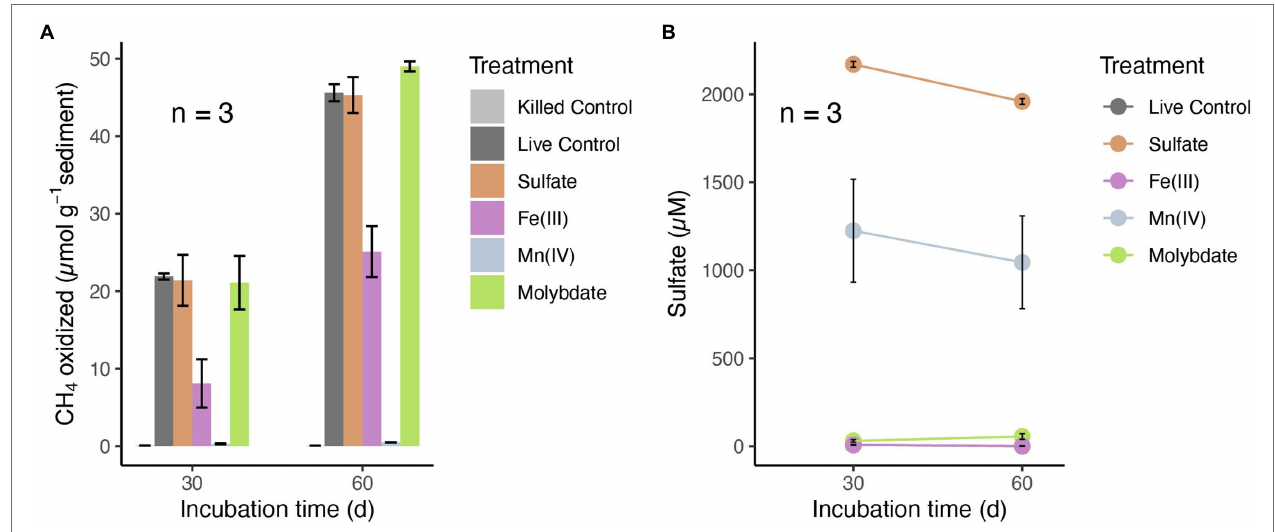
FIGURE 2 | (A) Methane oxidation in anoxic slurries with 14 C-labeled methane and different electron acceptors: sulfate (2 mM), amorphous iron(III) oxides (5 mM) and manganese(IV) oxides (5 mM) after 30 and 60 days, respectively. (B) Sulfate concentrations in the incubation supernatants of different treatments after 30 and 60 days. Control incubations were conducted without electron acceptors added. No methane oxidation rates were detected in base-killed controls (pH > 13). Error bars represent standard error of the mean ( n = 3). Sulfate was below or close to the detection limit in the live controls and in incubations with Fe(III) (points are